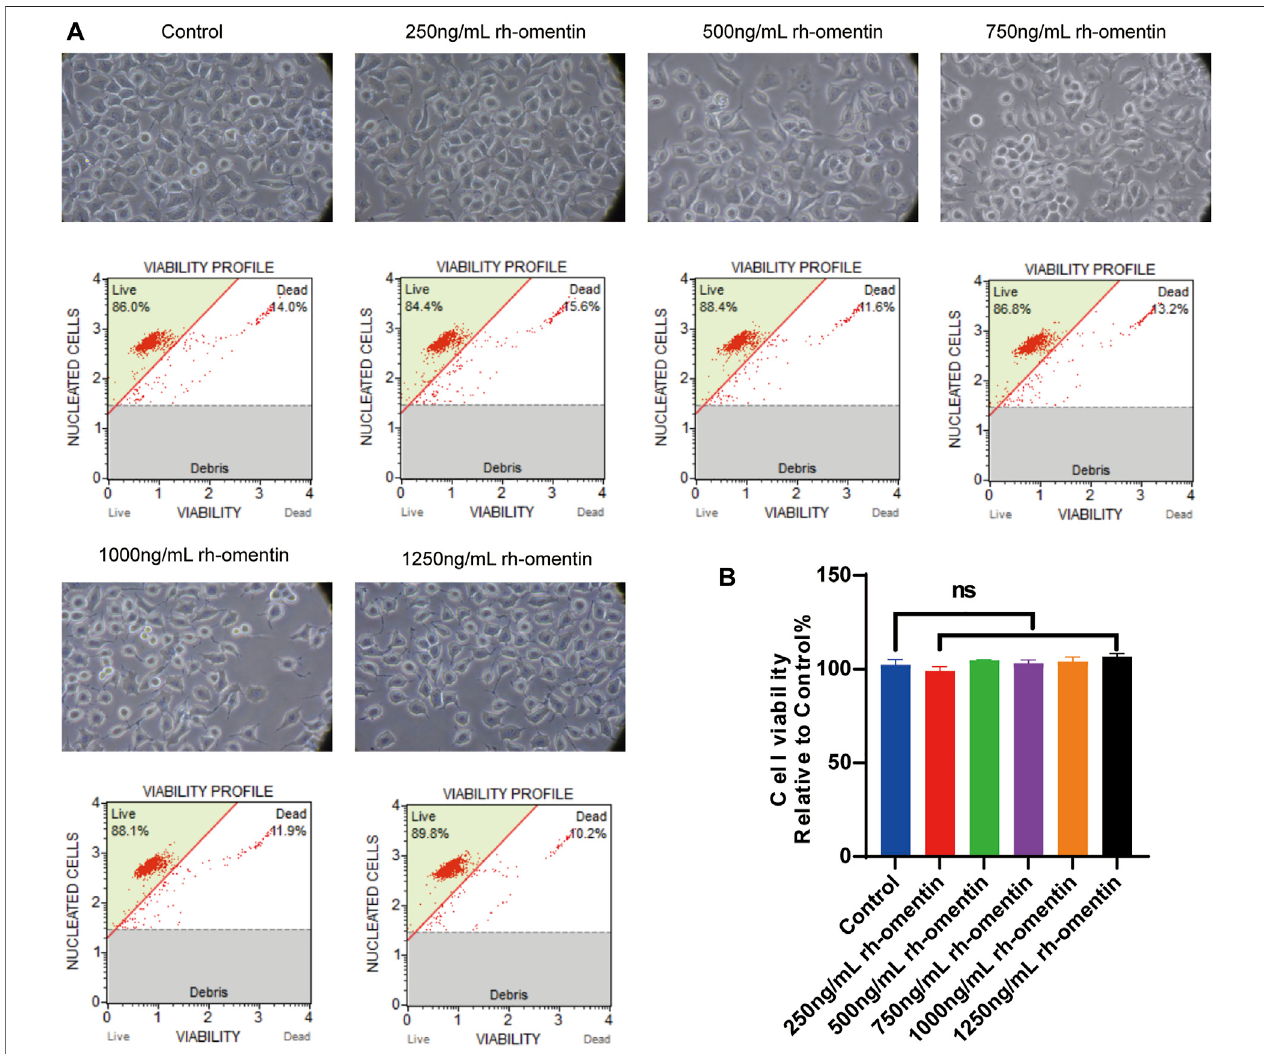
FIGURE2| Toxiceffectofrh-omentinonN2acells. (A) N2acellsweretreatedwithrh-omentinatthedifferentconcentrations(250,500,750,1,000or1,250 ng/ml) for 24 h. Cell morphology was observed under an inverted/phase contrast microscope, and images were obtained. (B) Statistical graph of cell viability. Error bars show the standard deviation for n (cid:2) 6 measurements from representative experiments. ns, non-signifcant.